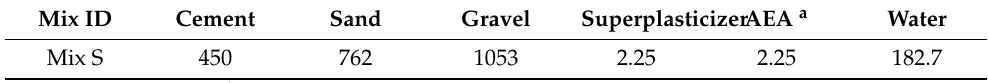
Table 1. Mix proportions of the parent material receiving the repair (kg/m 3